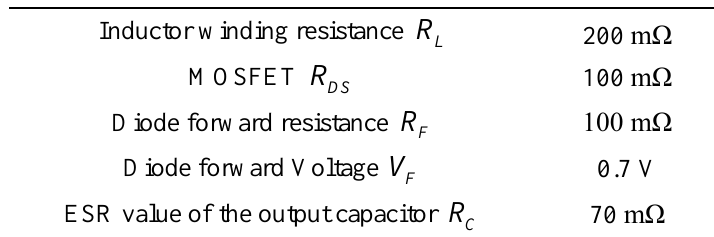
Table 2. Measured parasitic parameters.